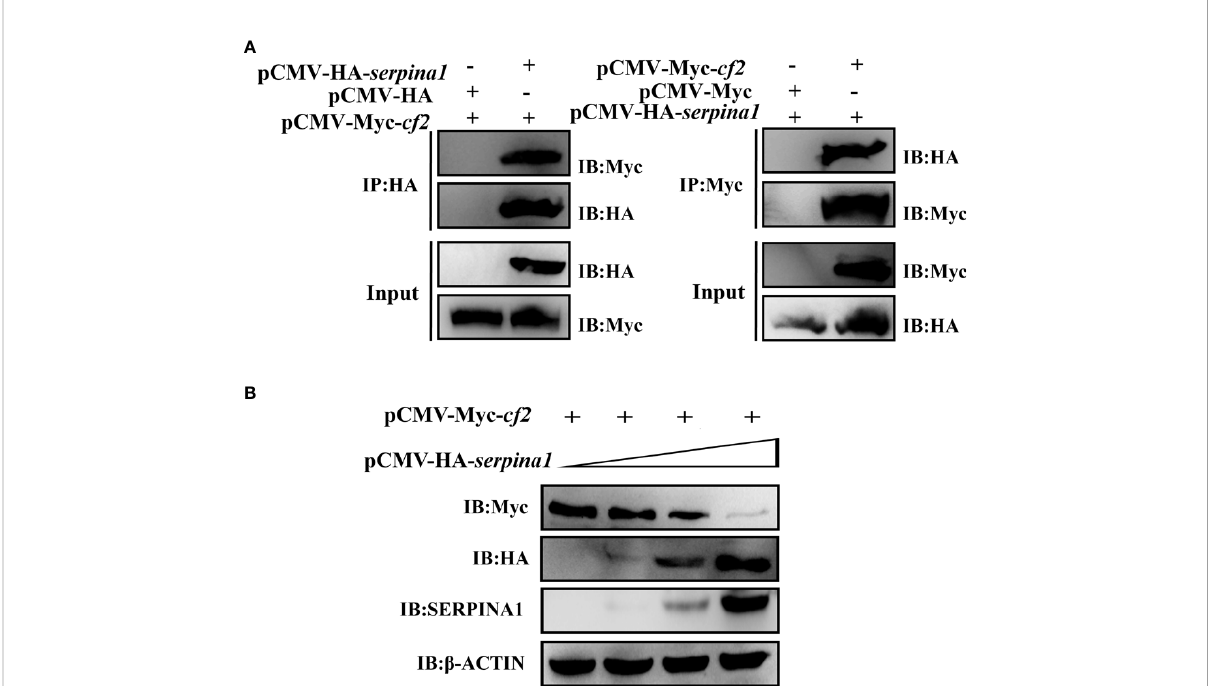
FIGURE 3 In vitro cellular assay demonstrating the interaction between SERPINA1 and CF2 in a dose-dependent manner. (A) CoIP veri fi es that SERPINA1 and CF2 interact with each other in 293T cells. “ IP ” indicates immunoprecipitation experiments with af fi nity samples incubated with HA or Myc antibodies, and “ IB ” indicates immunoblotting experiments with HA or Myc antibodies. (B) Western blot to detect the degradation of CF2 by SERPINA1. “ IB ” indicates immunoblotting experiments on protein samples with HA, Myc, SERPINA1, or b -ACTIN